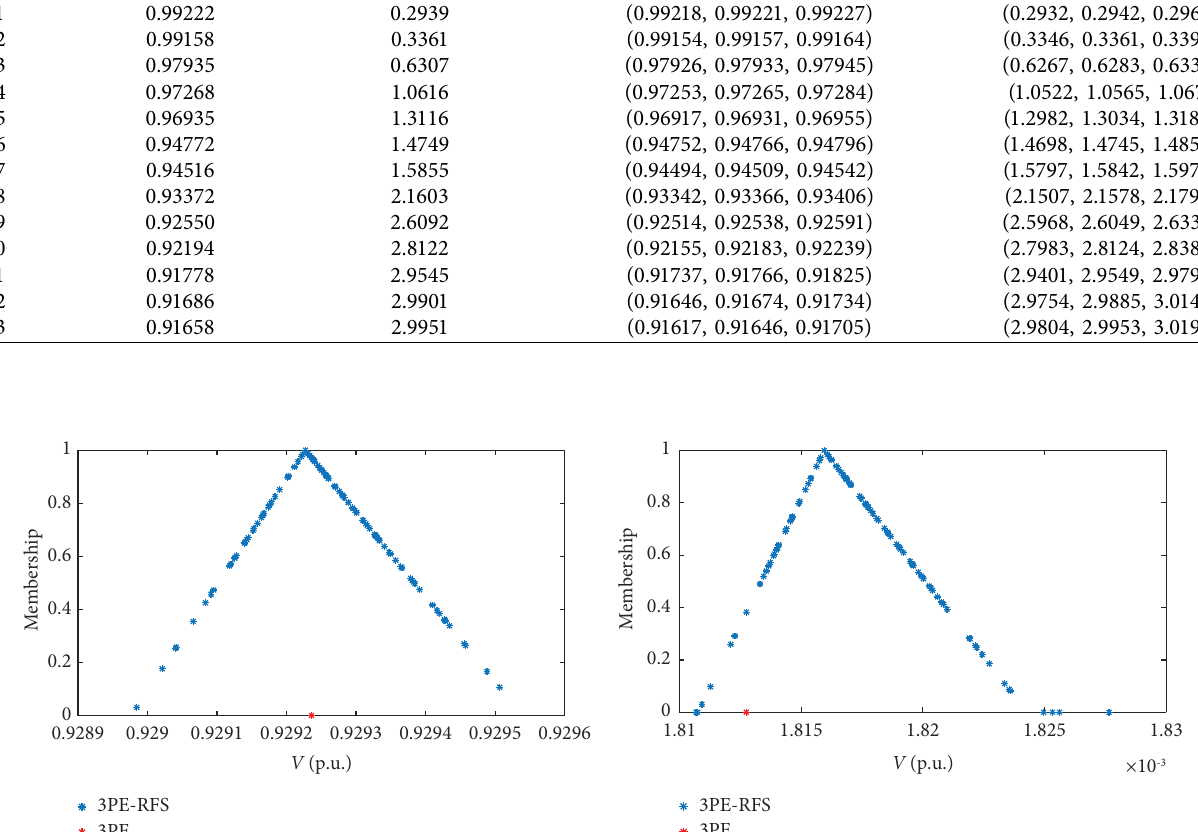
of bus 10. (a) Mean value. (b) Variance m